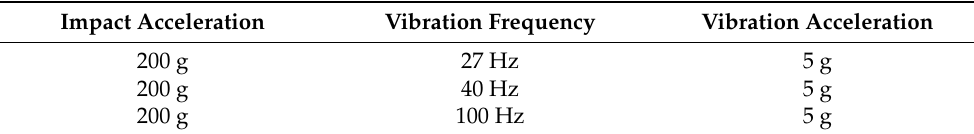
Table 2. Experimental conditions specified according to the Chinese GJB65B standard.